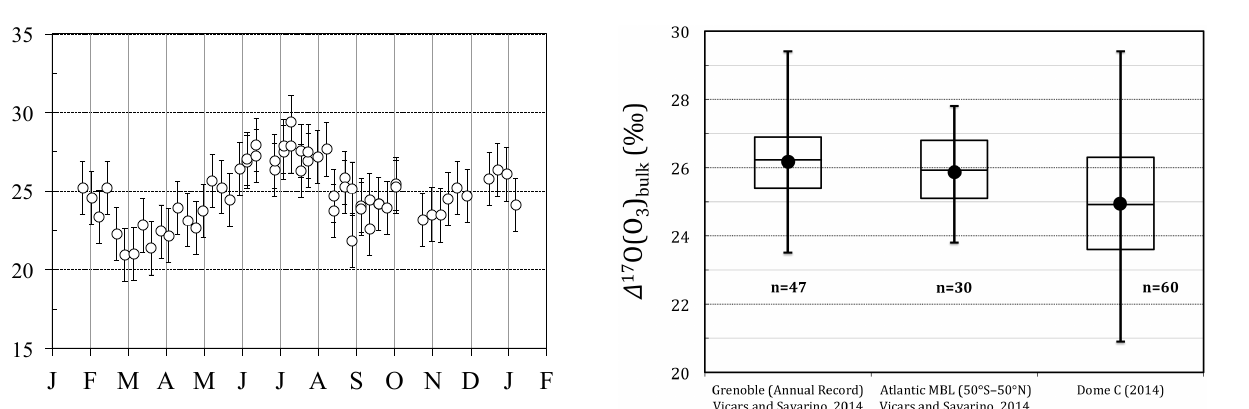
Figure 3. (cid:49) 17 O(O 3 ) bulk values for the 60 ambient air samplings done at Dome C throughout 2012. Vertical error bars refer to the total uncertainty estimated for the technique ( ± 1.7‰).